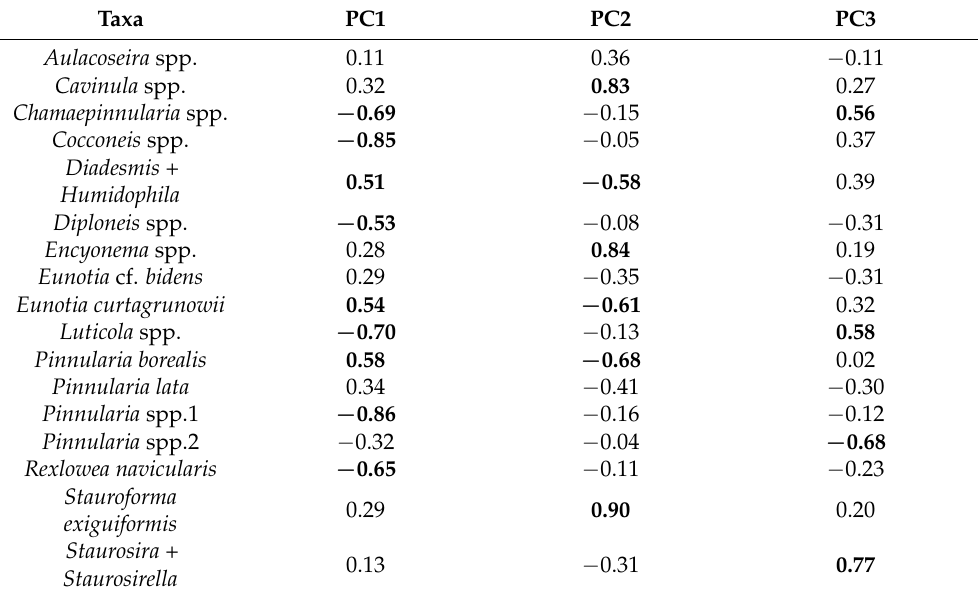
Table 2. Factor loadings (based on variable-component correlations) for the first three components. Bold type indicates cases of moderate or strong